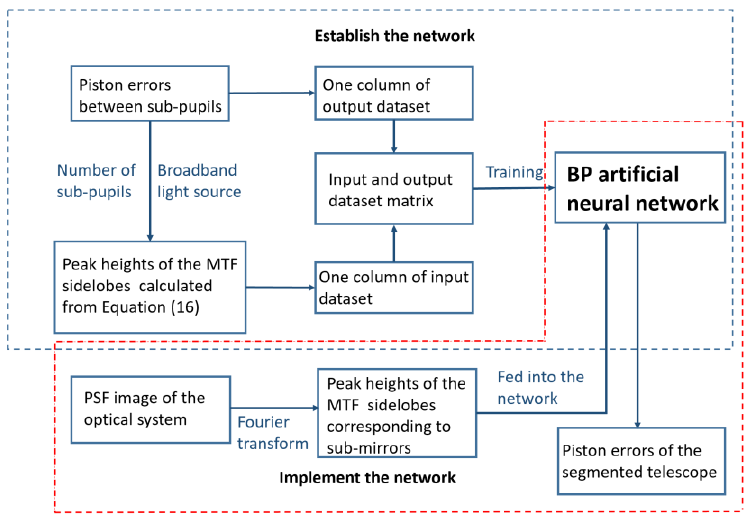
Figure 5. The detailed piston error detection approach with a BP artificial neural network.